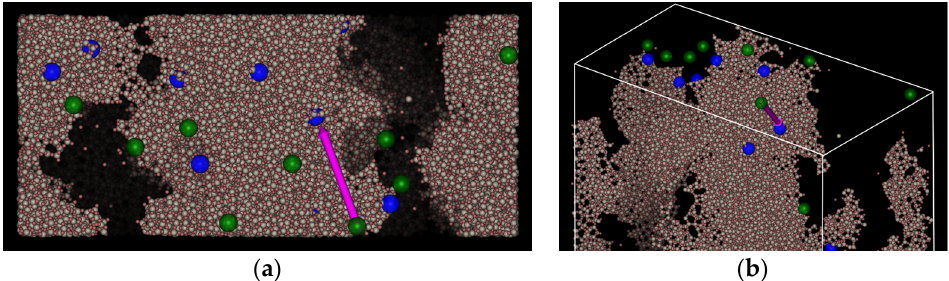
Figure 1. ( a ) Illustration from the top of a deposition step with a glancing angle of incidence of 50° directed to the top-left. Atoms to be deposited (green) are placed at the top and moved towards the structure keeping the limits of the interaction cutoff. The blue marked atoms indicate the direction of the depositing atoms and would be hit without any interaction, also indicated by the pink arrow. ( b ) 3D view of the same illustration with the dimension of the simulation box. Graphics generated with NGL [16,17].